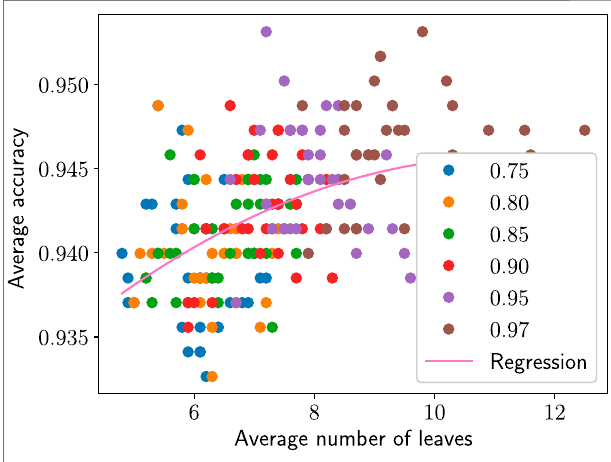
FIGURE 3 | Average accuracy vs. average number of leaves for each GMT parameter set applied to the Wisonson breast-cancer data. The color indicates which parameter q ∈ { 0 . 75 , 0 . 8 , 0 . 85 , 0 . 90 , 0 . 95 , 0 . 97 } was chosen. We include a quadratic regression of the